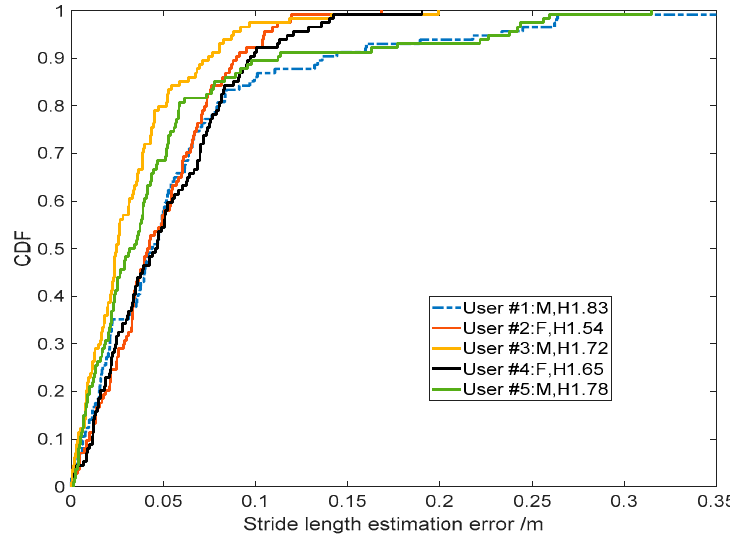
Figure 16. Robustness among different pedestrians.